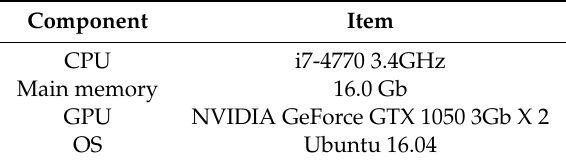
Table 2. Specifications under which the learning algorithm operates.